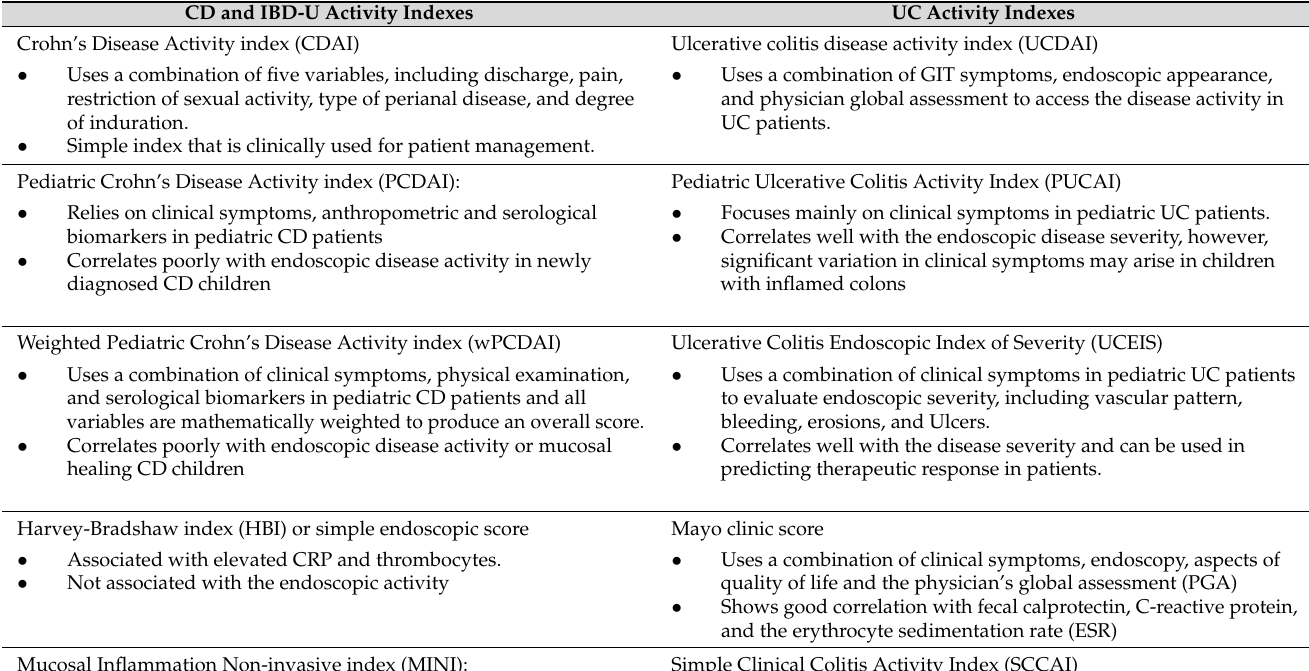
Table 1. Commonly used IBD activity indices to measure the disease